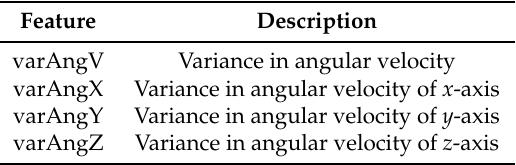
Table 2. Features used in the ANN for user state